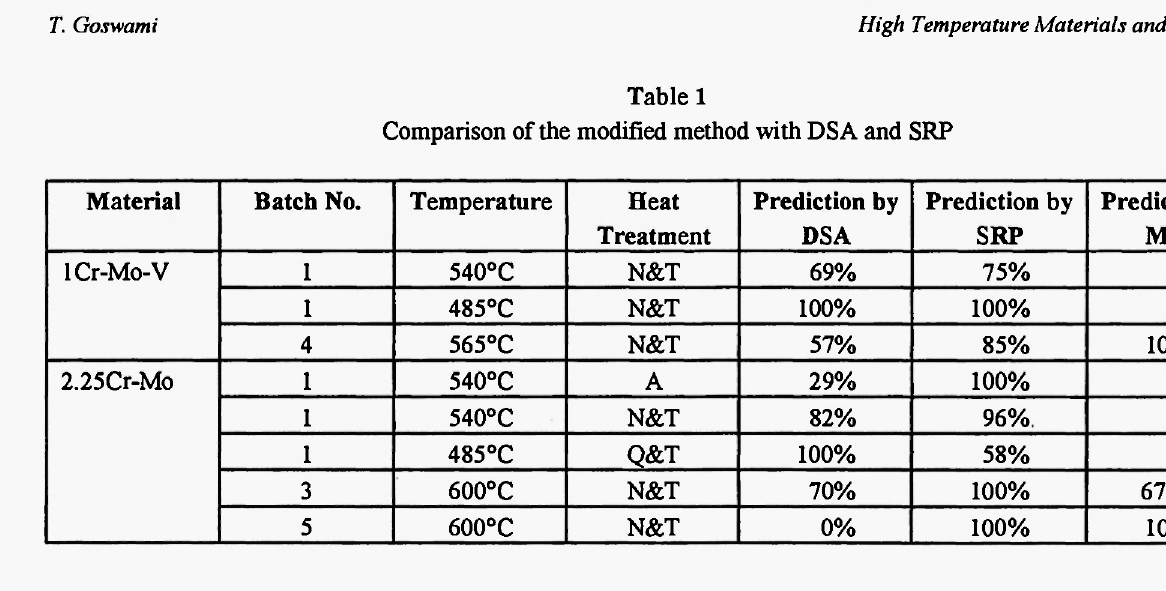
Comparison of the modified method with DSA and